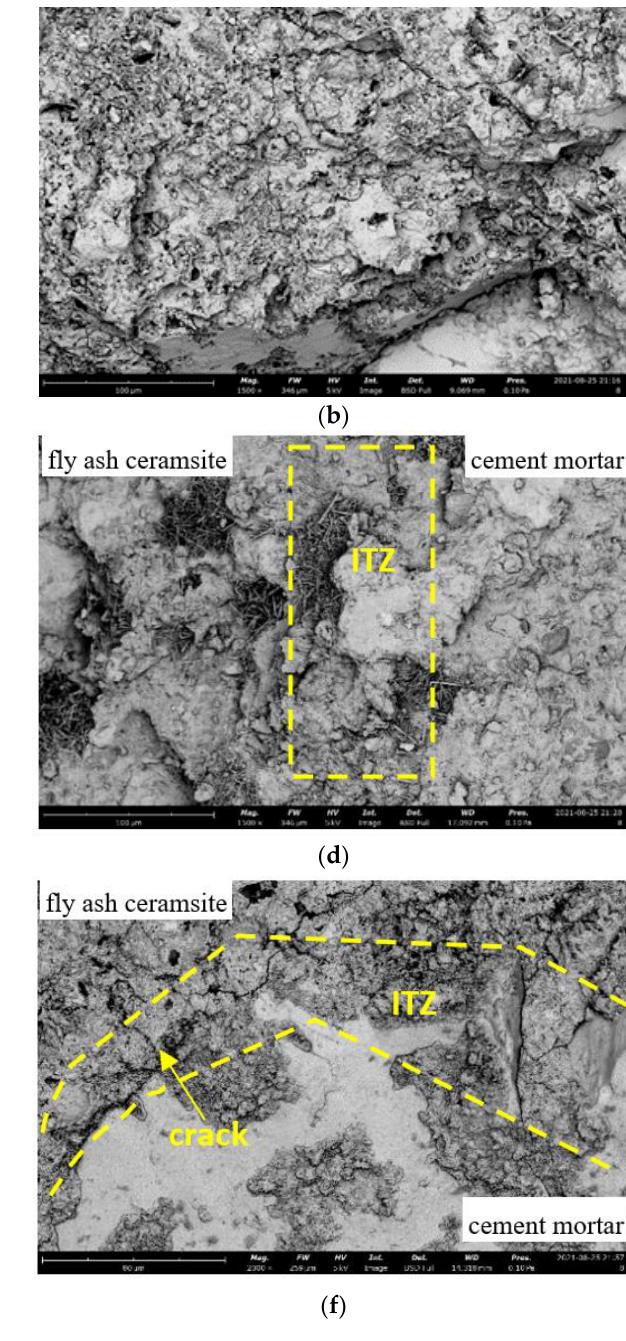
Figure 11. The SEM micrographs of ceramsite aggregate concrete. ( a ) Ceramsite aggregate surface (LAC30-1-0), ( b ) cement mortar (LAC30-1-0), ( c ) the interface between ceramsite aggregate and cement mortar (LAC30-1-0). ( d ) The interface between ceramsite aggregate cross-section and cement mortar (LAC30-1-6). ( e ) The interface between ceramsite aggregate and cement mortar (LAC30-12-6). ( f ) The interface between ceramsite aggregate cross-section and cement mortar (LAC30-1-30).